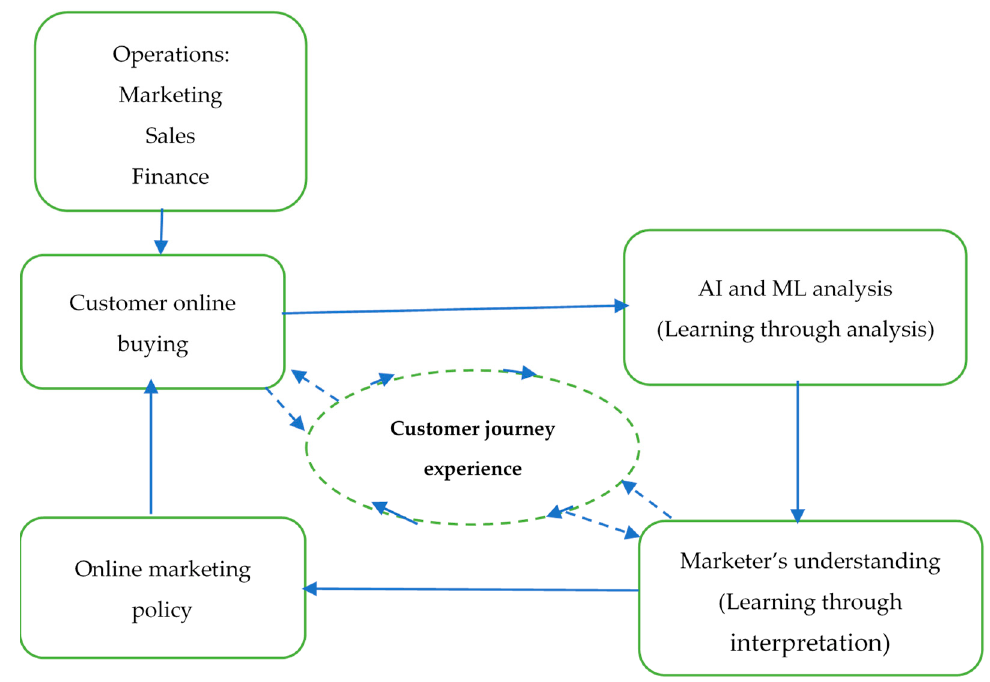
Figure 1. The process of renewing online marketing policy. Source: The authors.